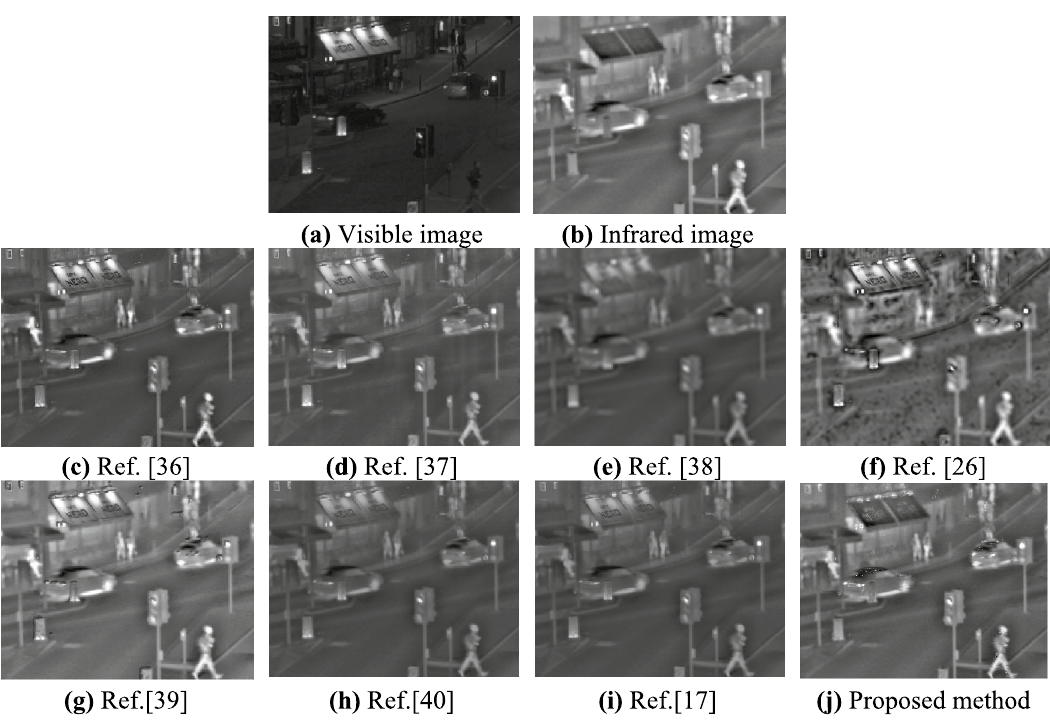
Figure 6. Visible and infrared images (CSSN) and their fusion